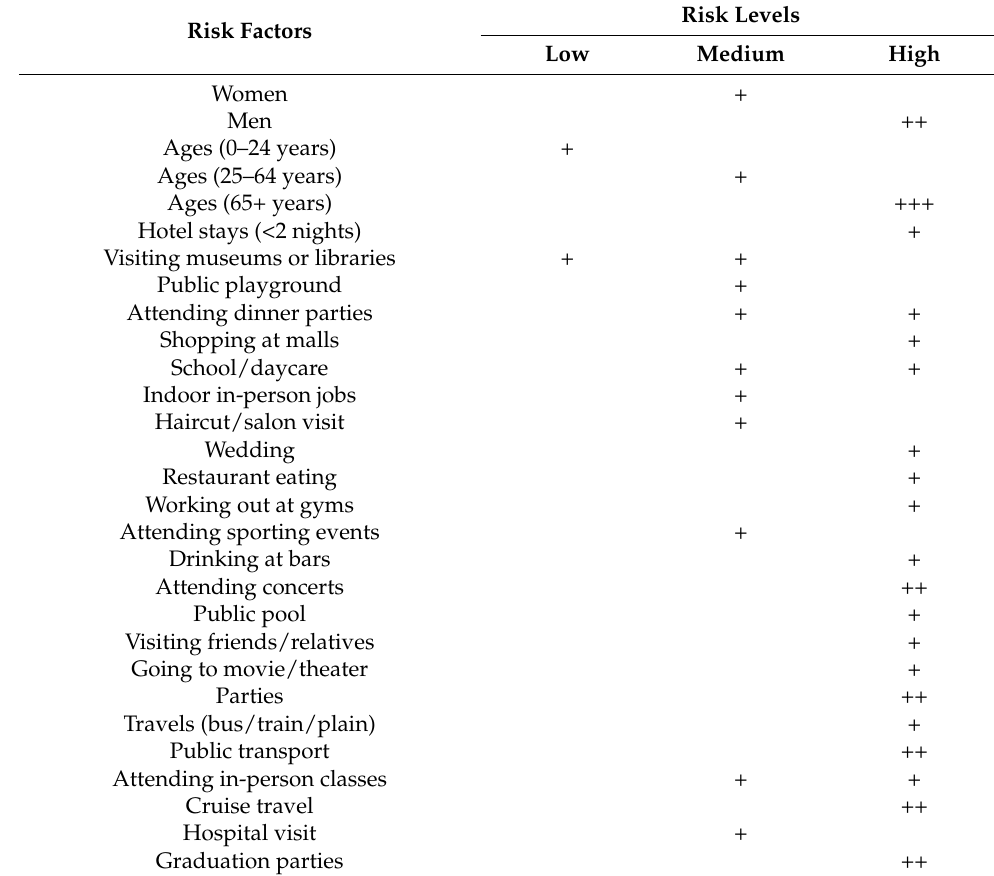
Table 1. Relative levels of various risk factors for COVID-19